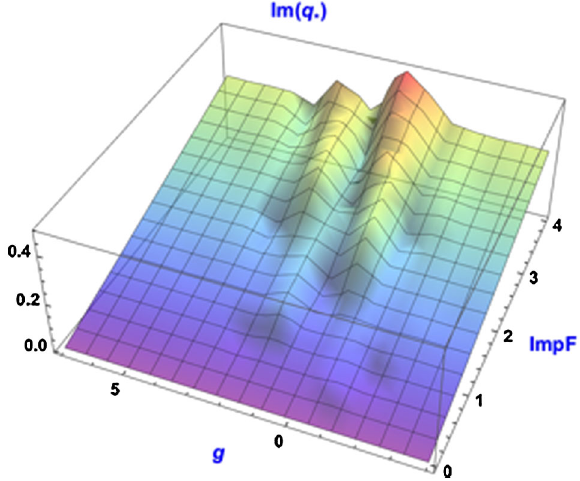
FIG. 29. Threshold current of the Landau octupoles, in Amperes, for the same case as Fig. 28, computed according to Ref. [5].